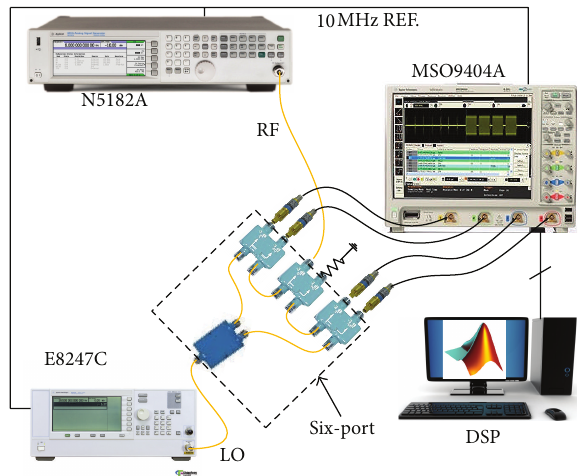
Figure4:Completetestsetupforthesix-portbasedcommunication